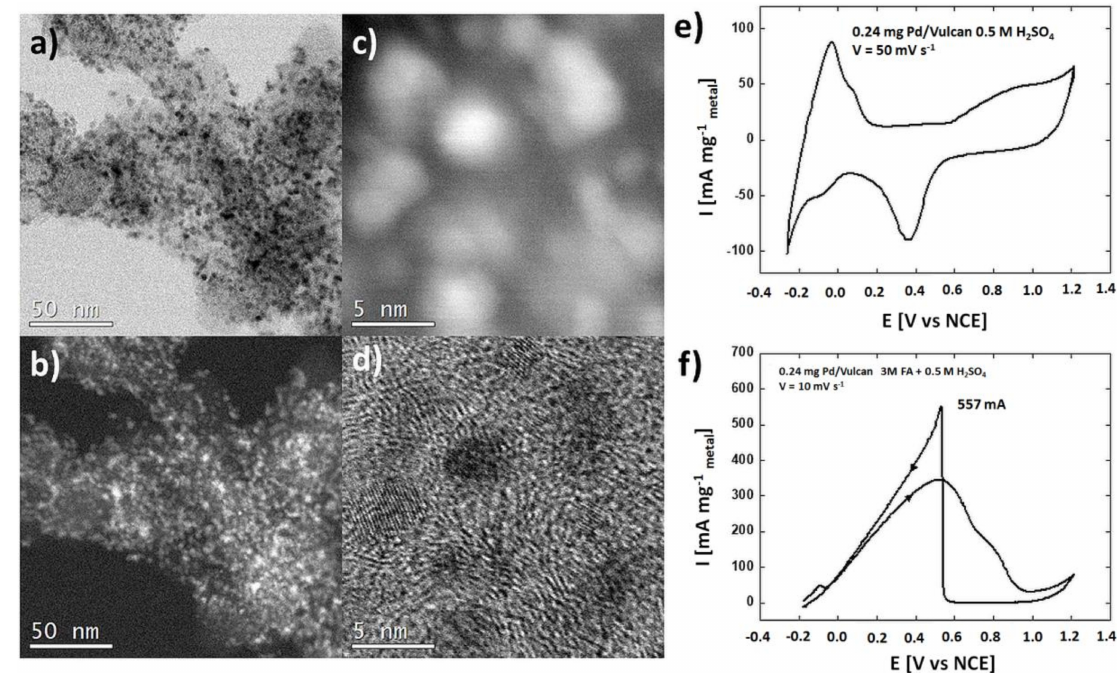
Figure 7. STEM images of the commercial Pd / Vulcan catalyst:( a ) BF-STEM (Z-contrast), ( b ) HAADF-STEM (Z-contrast), ( c , d ) HR STEM images of the single Pd nanoparticles within a carbon matrix, and ( e , f ) cyclic voltammograms as measured on this material in 0.5 M H 2 SO 4 and 0.5 M H 2 SO 4 + 0.5 M HCOOH ( e , f